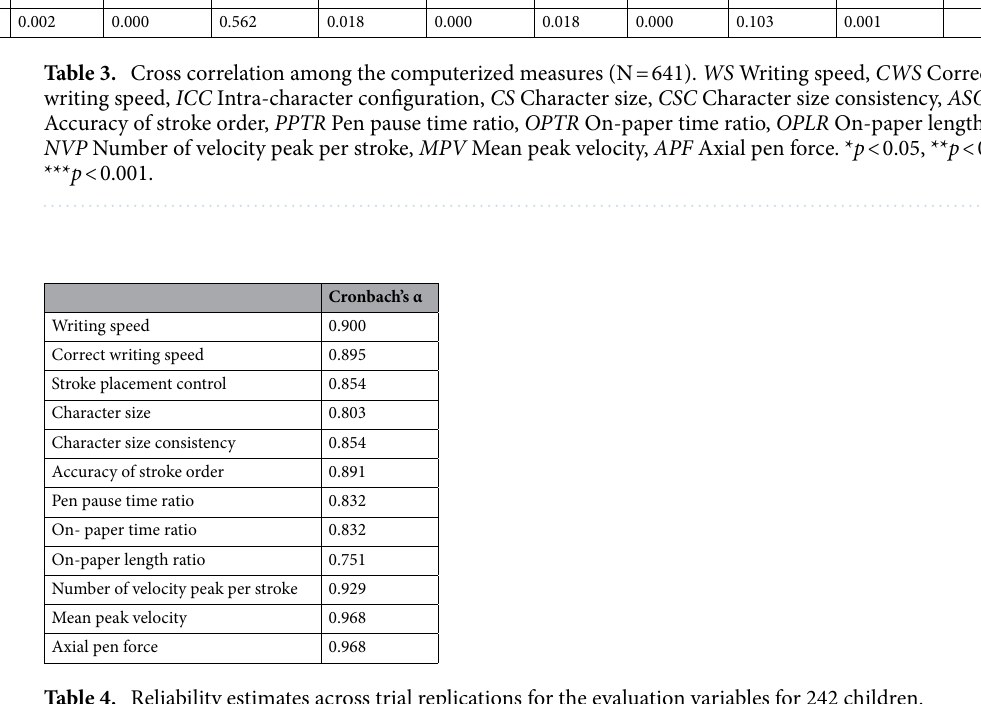
Table 4. Reliability estimates across trial replications for the evaluation variables for 242